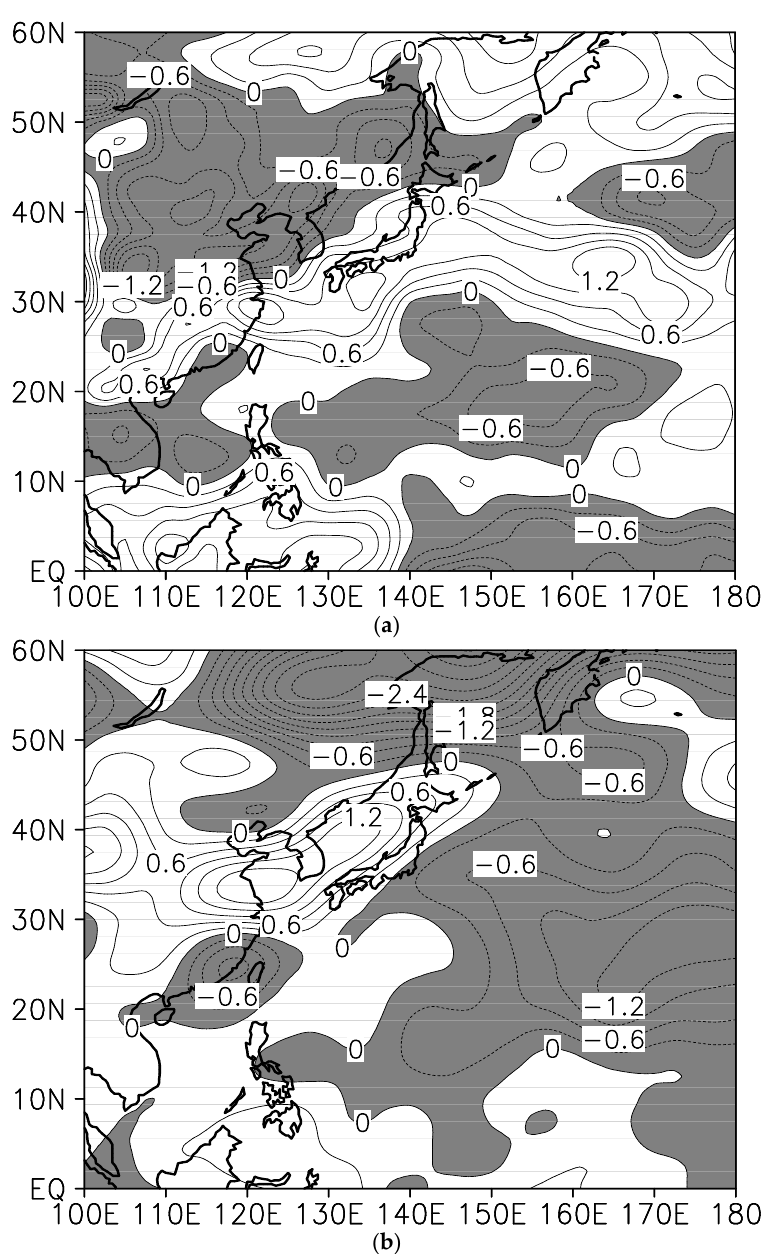
Figure 9. Same as in Figure 4, but for ( a ) 850 hPa specific humidity and ( b ) 850 hPa air temperature. Contour intervals are 0.3 g·kg −1 for 850 hPa specific humidity and 0.3 °C for 850 hPa air temperature. Shaded areas denote negative values